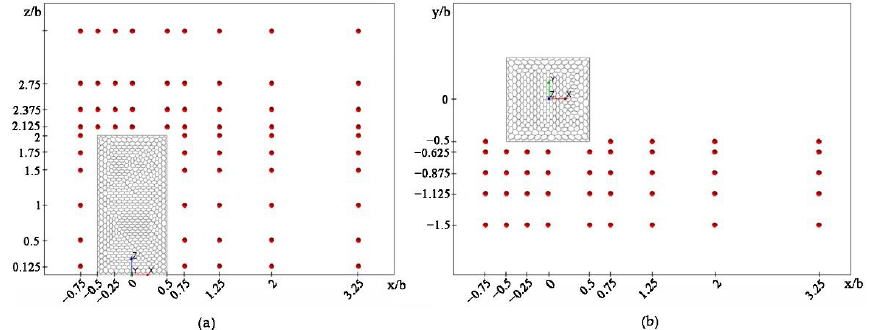
Figure 5. Distribution of wind-speed test points: ( a ) distribution on the xz-plane (y = 0), ( b ) distribution on the xy-plane (z = 0.125b and z = 1.25b).